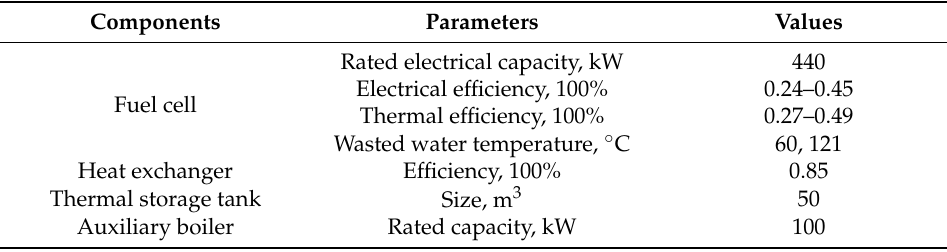
Figure 3. Interface of the fuel-cell-based CHP system simulation in the TRNSYS software. Table 2. Parameters of the main components used in the system